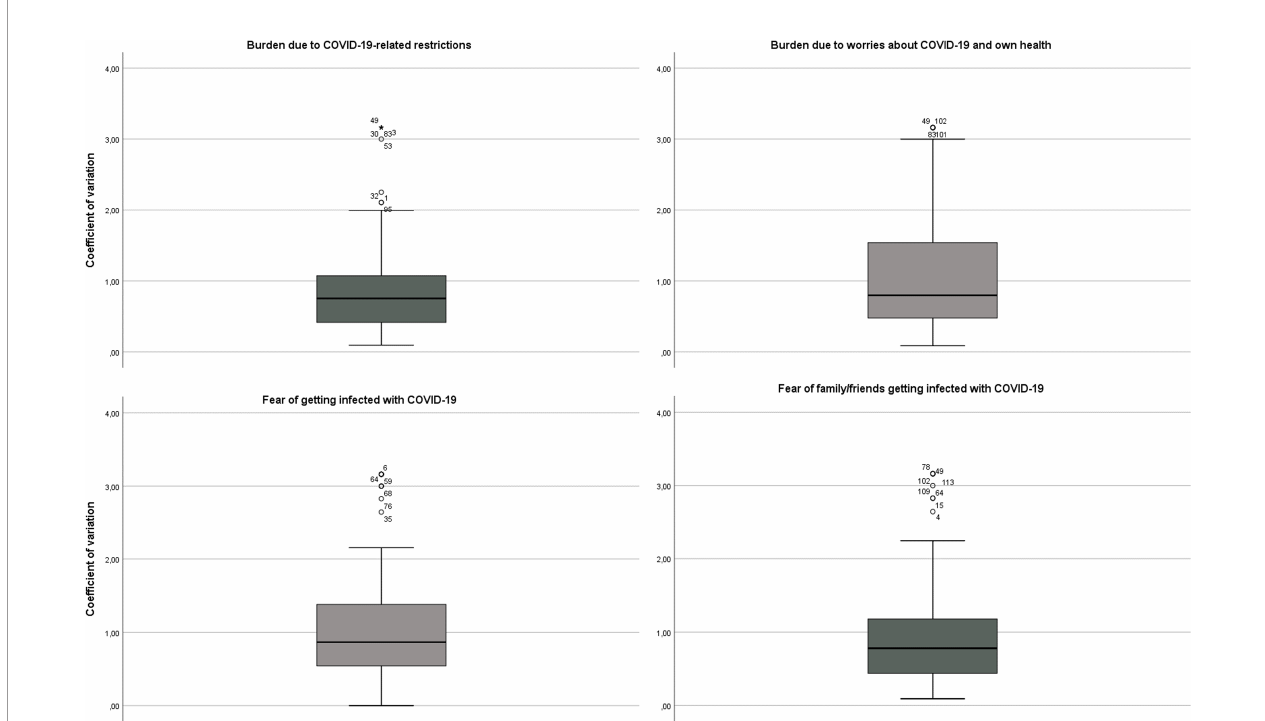
FIGURE 3 | Boxplots displaying variability (CV) of COVID-19-related burdens and fears. Data are bowled line = median; box upper line = 75%; low line = 25%; lower end line = minimum; upper end line =